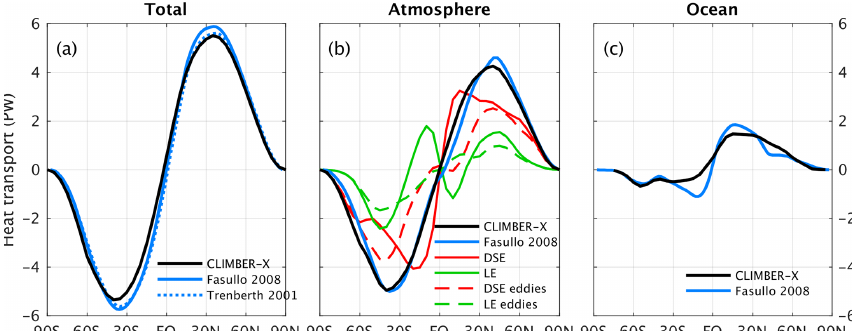
Figure 2. Meridional energy transport. (a) Total simulated meridional energy transport by ocean and atmosphere compared to observations (Trenberth and Caron, 2001; Fasullo and Trenberth, 2008). (b) Meridional energy transport by the atmosphere compared to estimates from Fasullo and Trenberth (2008) and modelled decomposition into dry static energy (DSE) and latent heat (LE) fluxes and contribution by eddies. (c) Global ocean meridional energy transport compared to observations (Fasullo and Trenberth, 2008).